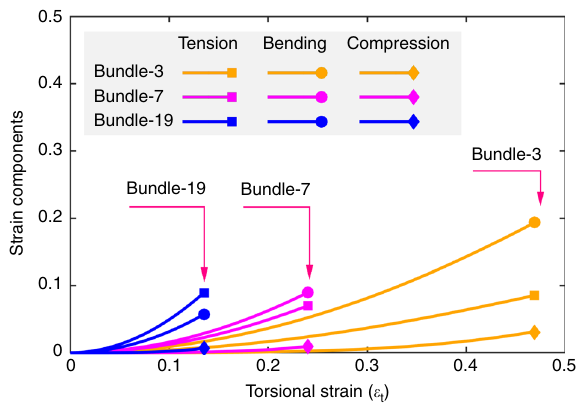
Fig. 7 Normalized gravimetric energy density of the nanothread bundles from the simulation. Here A and C denote nanothread-A and nanothread- C, respectively.